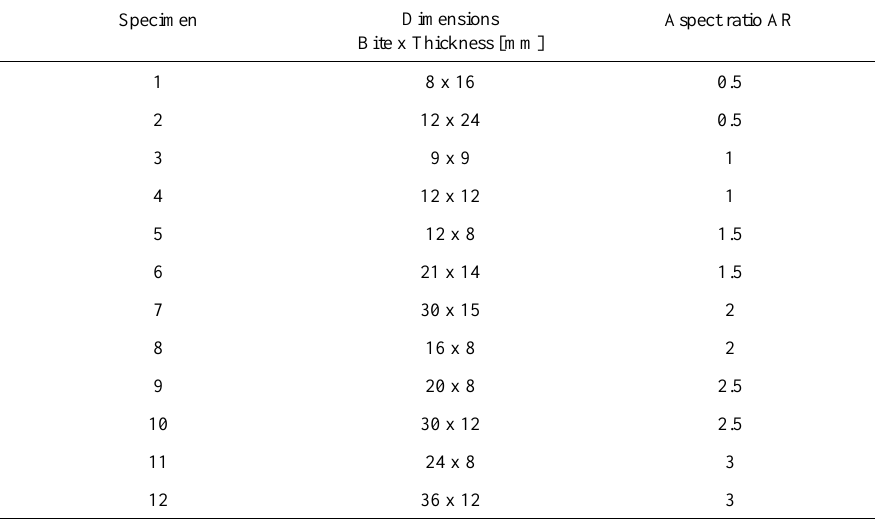
Table 1: dimensions of studied H-pieces (in mm) and corresponding aspect ratio (Bite w/Thickness e).